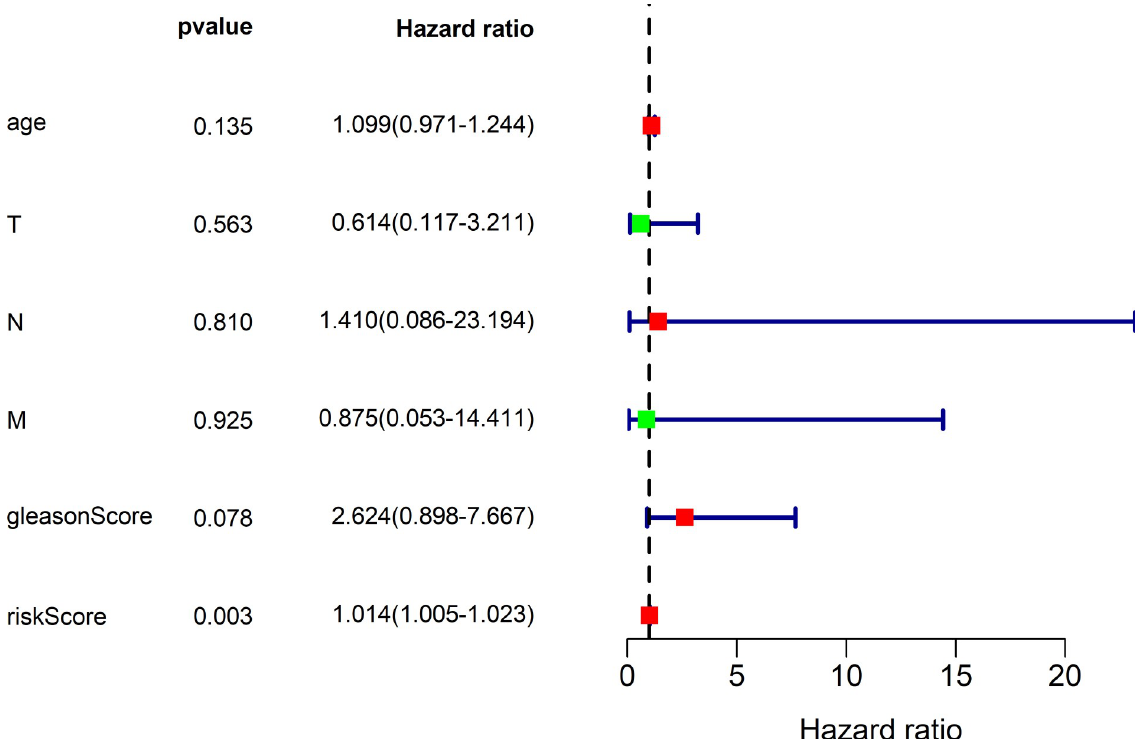
Fig 10. TCGA multivariate analysis results demonstrated the possibility to use the 4-lncRNA signature as the potent predicting factor for PCa OS rate from other clinicopathological factors. Red represents high risk indicators and green represents low risk ones.